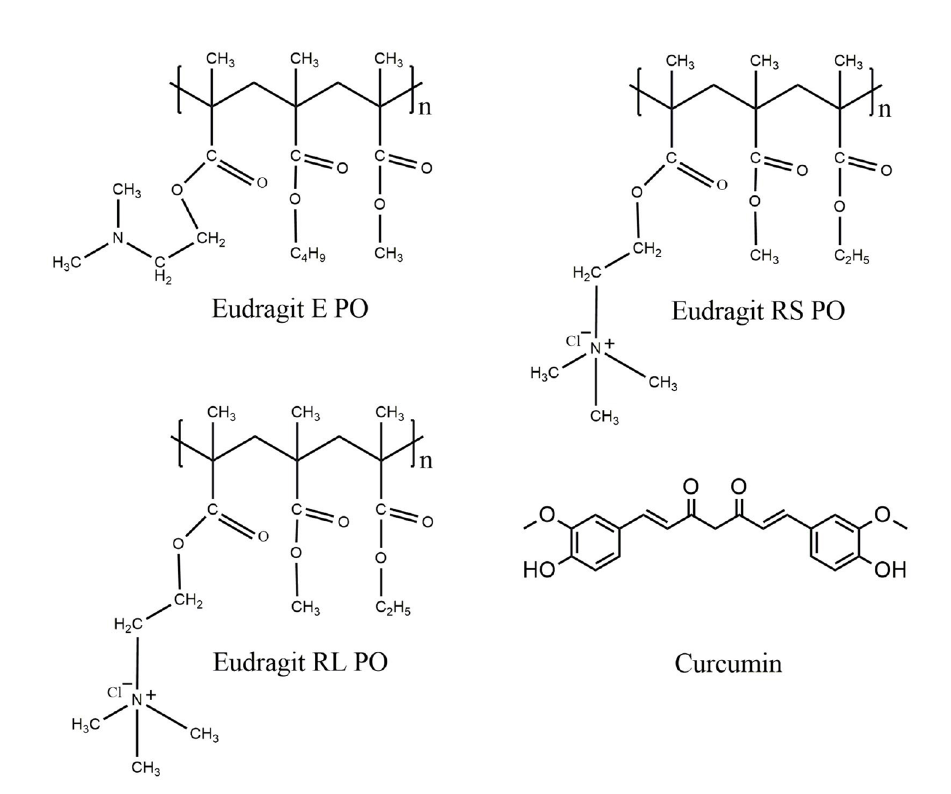
FIGURE 1 - Chemical structure of Eudragit E PO, Eudragit RS PO, Eudragit RL PO and curcumin. TABLE I - L oading ability of curcumin solid dispersion and their appearance Solid dispersion sample